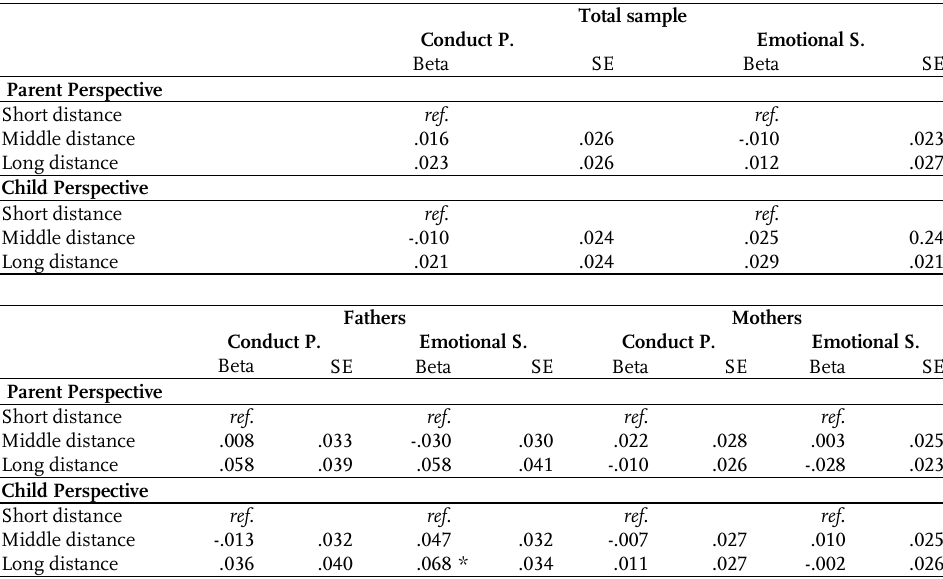
Table A : The Association between parental long-distance commuting and child well-being (measured by conduct problems and emotional symptoms (without parent-child relationship)) Total sample Conduct P. SE Beta SE Parent Perspective Short distance ref.